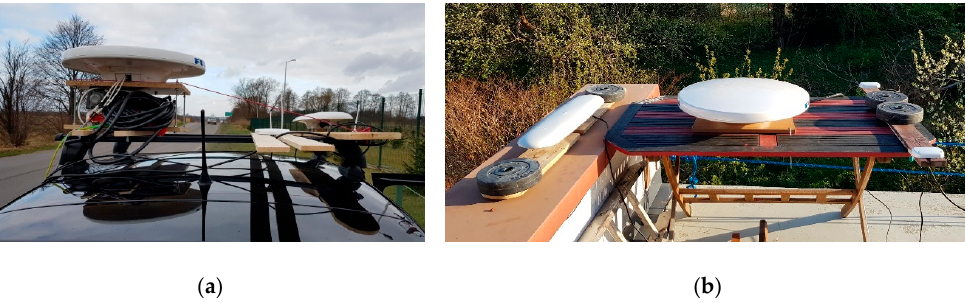
Figure 6. Experimental setup: ( a ) on a car roof for the automotive tests; ( b ) on a house roof for the stationary sets. Photo: K. Zwolak.